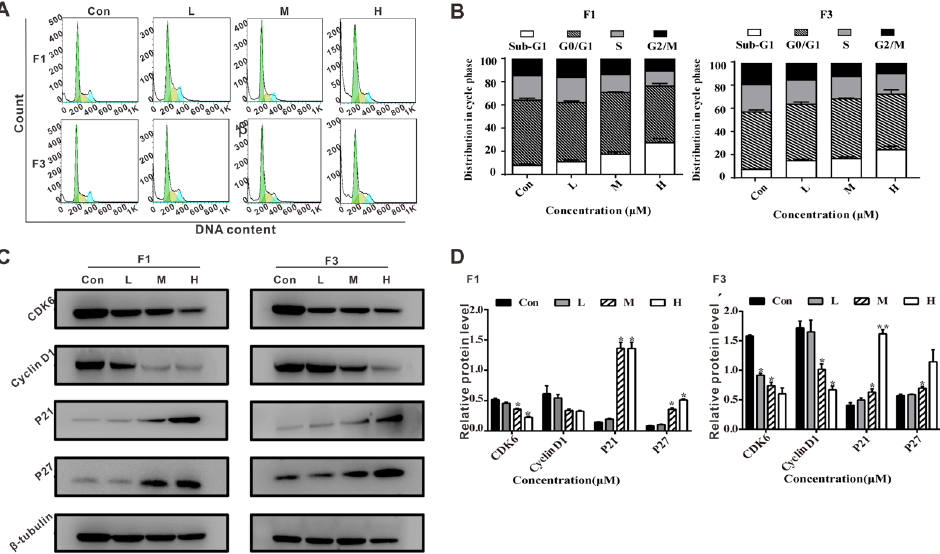
Figure 5. F1 and F3 triggered cell cycle arrest in Jurkat cells. ( A ) The cell cycle distribution of Jurkat cells treated with F1 or F3 at different concentrations (Sub-G1 phase, blank; G0/G1 phase, green; S phase, yellow; and G2/M phase, blue). ( B ) The histogram showed the distribution of cells (%) in Sub-G1, G0/G1, S, and G2/M phase. ( C ) The expression of CDK6, Cyclin D1, P27, and P21 in Jurkat cells treated by various concentrations of F1 or F3. β -tubulin was used as an internal control; ( D ) The histogram showed the relative protein levels in Jurkat cells treated by F1 or F3. Data were shown as mean ± SEM of three independent experiments; * p < 0.05 and ** p < 0.01 vs. the control group. The uncropped Western Blot images can be found in Figure